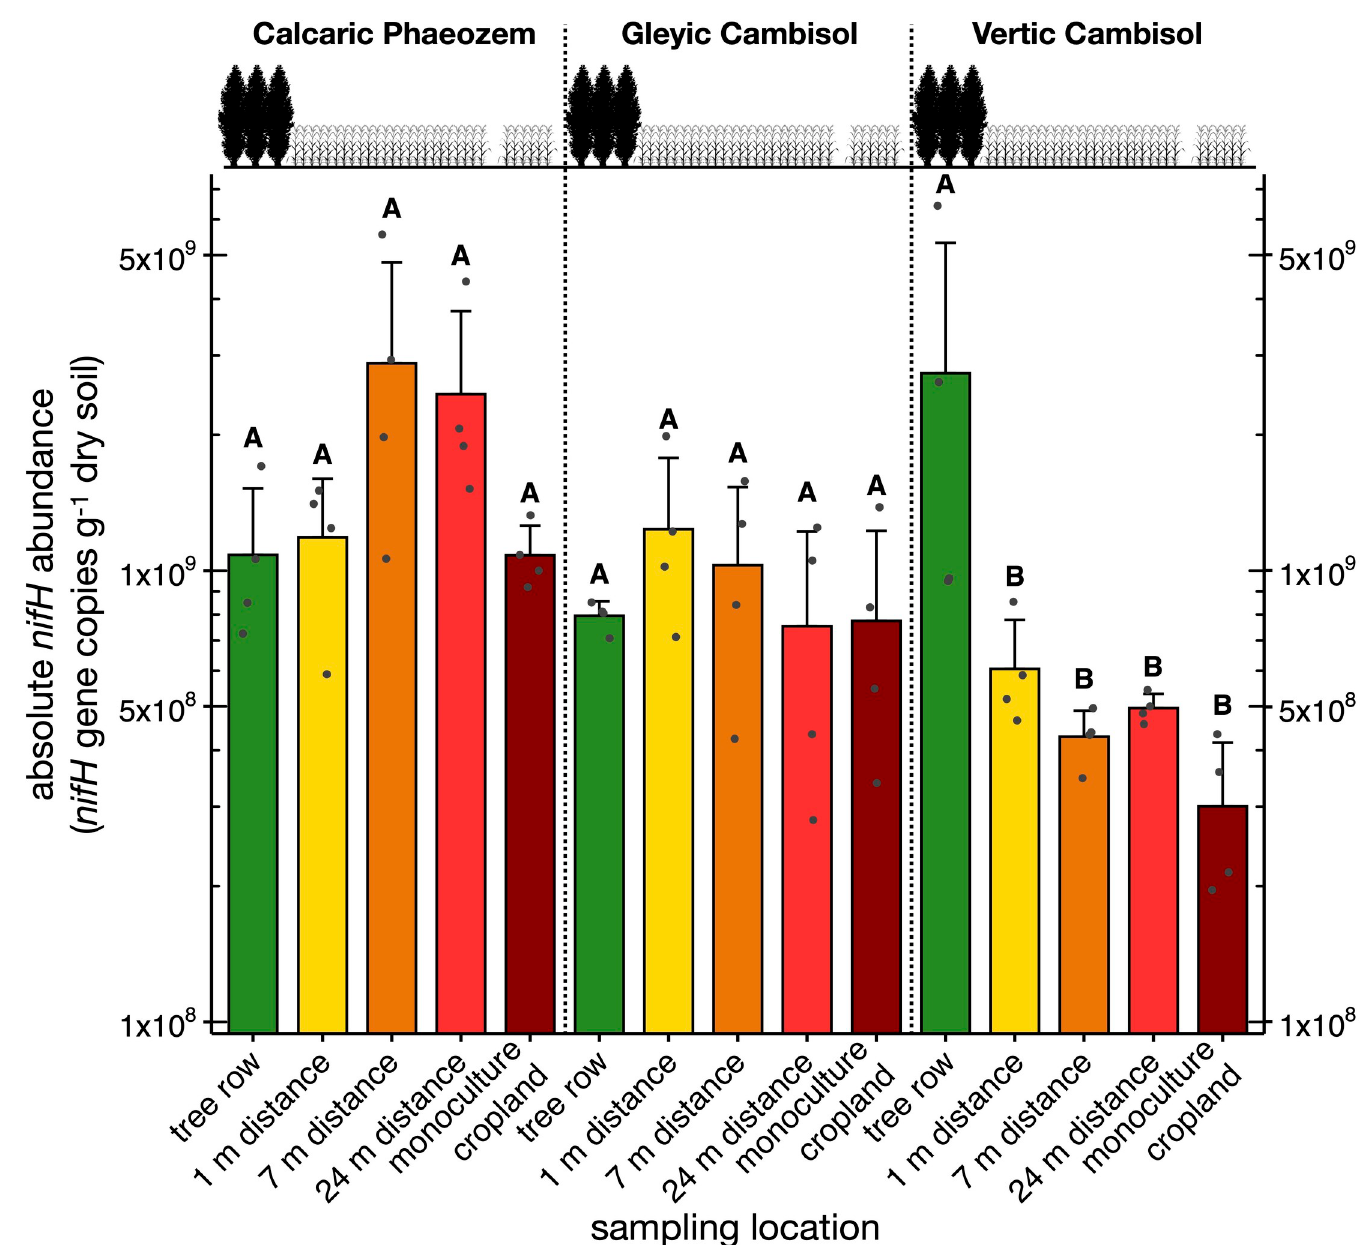
Fig 6. Abundance of N fixation gene nifH in paired temperate agroforestry and monoculture cropland systems in three different soil types. Samples in the agroforestry systems were collected in the tree row as well as at 1 m, 7 m, and 24 m distance from the tree row within the agroforestry crop row. Bars represent means with standard deviation ( n = 4 per soil type × sampling location). Different uppercase letters indicate significant differences among the sampling locations within the same soil type (one-way analysis of variance with Tukey’s honestly significant difference test or Kruskal–Wallis test with multiple comparison extension). https://doi.org/10.1371/journal.pone.0246919.g006 greater bacterial abundance in plots with trees than without trees in Canadian agroforestry sys- tems. Also in line with the findings of Banerjee et al . [27] temperate agroforestry did not affect the Shannon diversity of the soil bacterial ASVs (Fig 4A). The evenness of soil bacterial ASVs was lower in the tree rows than in the arable land of the two agroforestry systems planted with summer barley (Calcaric Phaeozem and Gleyic Cambisol soil) (Fig 4B), revealing that the tree